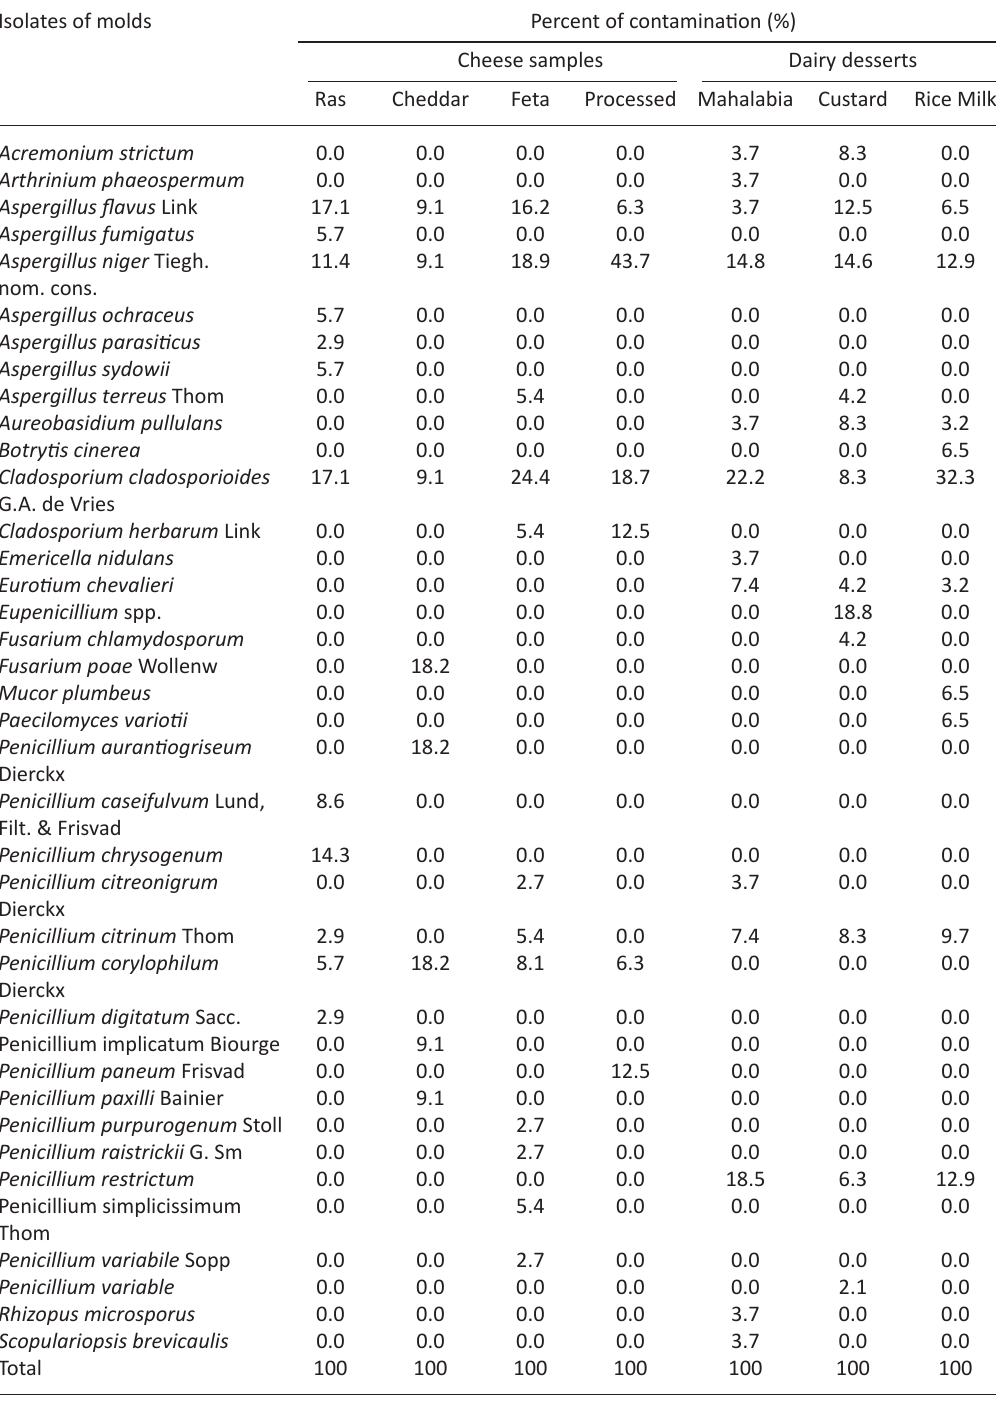
Table 2. Percent of contamination of mold isolates in different dairy products samples (n = 20) Isolates of molds Percent of contamination (%) Cheese samples Dairy desserts Ras Cheddar Feta Processed Mahalabia Custard Rice